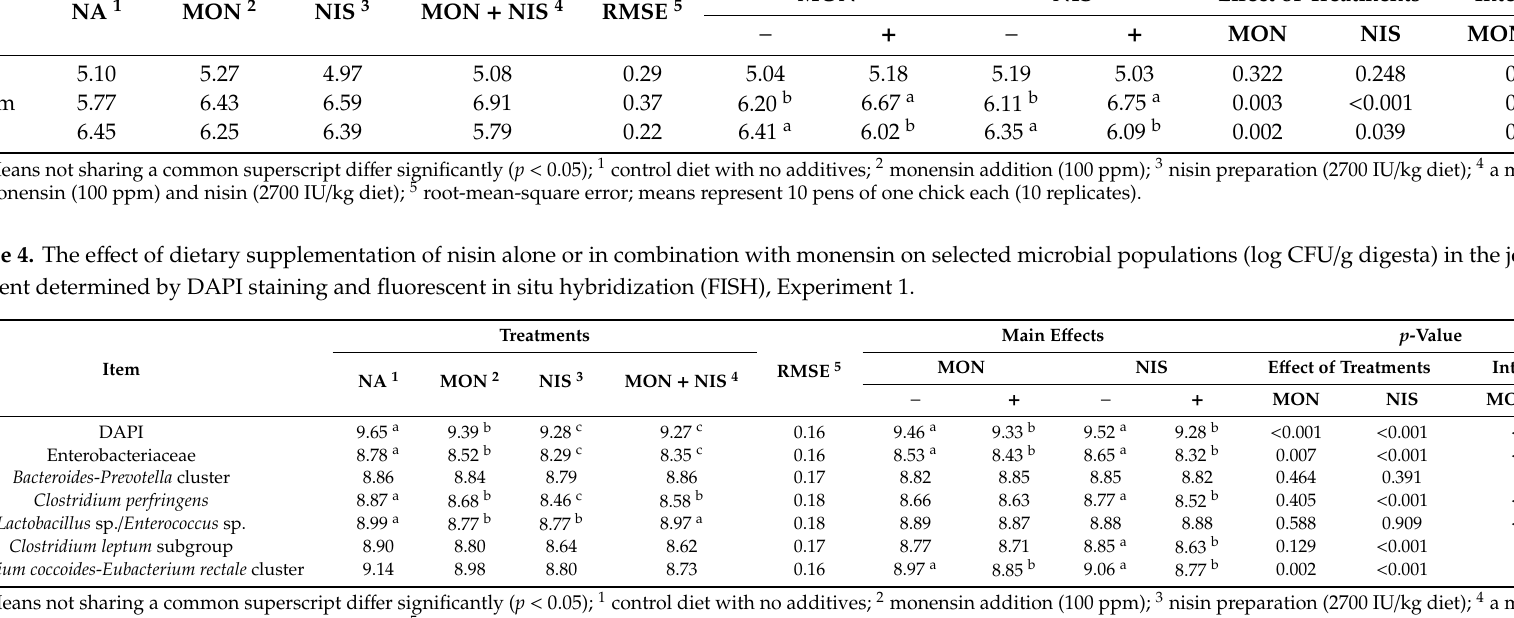
E ff ect of Treatments